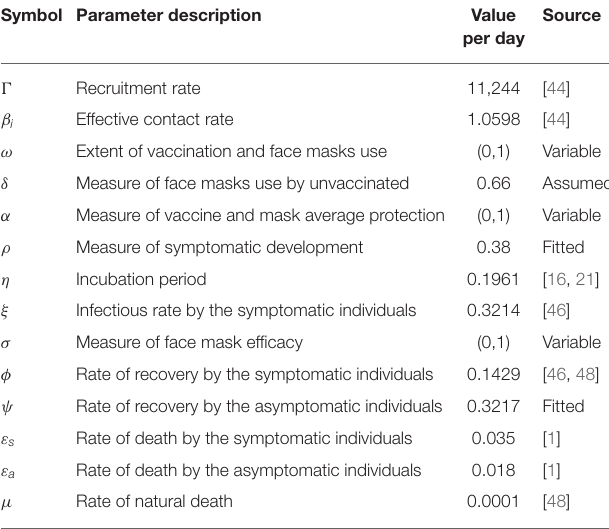
TABLE 1 | Parameter description for the model (Equations 2–8) and their estimated